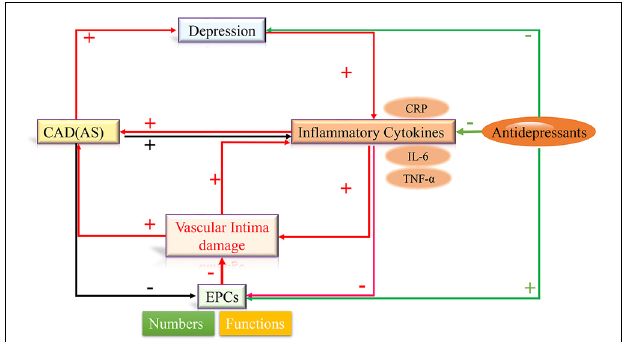
FIGURE 2 | Inflammatory cytokines, depression, CAD, and EPCs dysfunction generate a positive feedback loop. Depression increases the levels of circulating inflammatory cytokines, such as CRP, TNF- α , IL-6 etc., which damage vascular intima, decrease the number of EPCs, and inhibit the functions of EPCs. Dysfunction of EPCs cannot repair the impaired vascular intima, which further stimulates the release of inflammatory factors and induces the development of atherosclerotic cardiovascular. Antidepressants, that inhibit inflammatory cytokines, may reduce the risk of mortality from CAD through improving EPCs functions and repairing intima